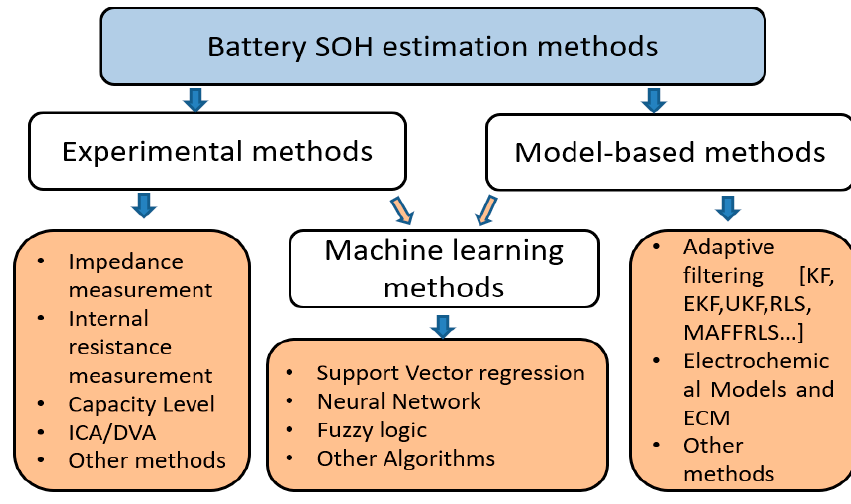
Figure 1. State of Health (SOH) estimation methods.